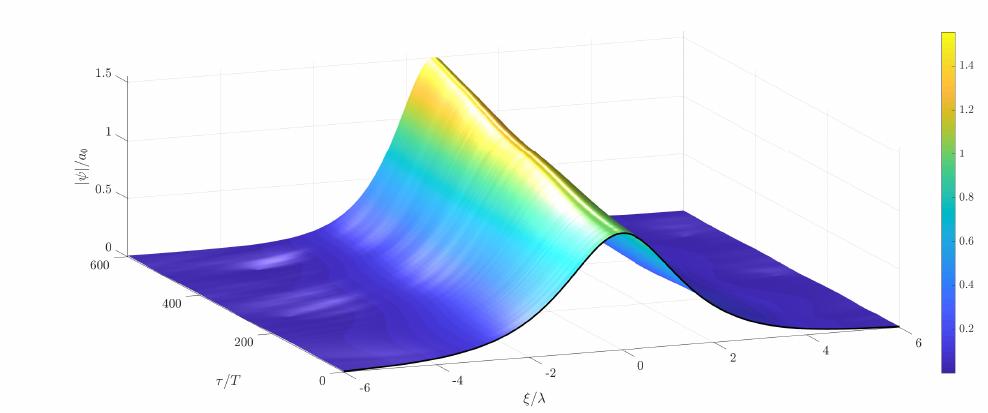
Figure 12. Temporal evolution of a soliton solution of the stochastic modified Schrödinger equation (MNLS) with non-white noise excitation in time, mean wind velocity V m = 14 m/s and σ v = 1 m/s.